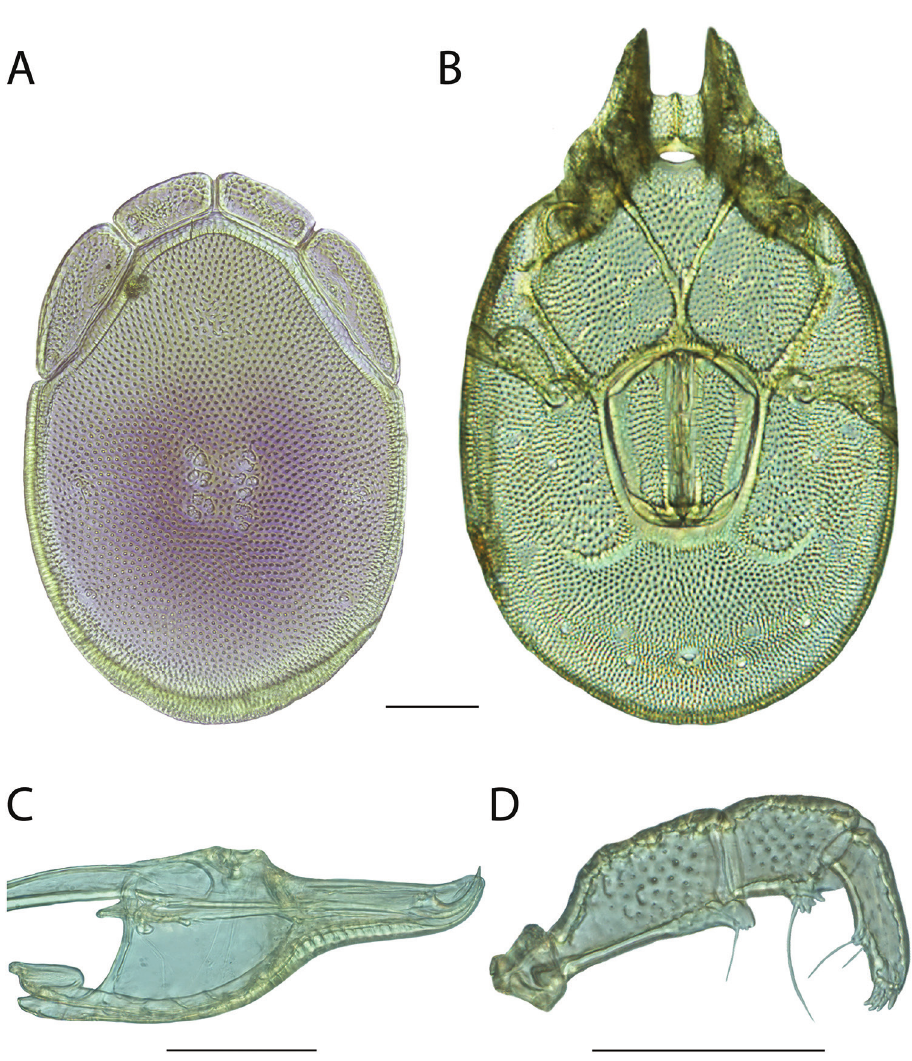
Figure 141. Torrenticola manni sp. n. female: A dorsal plates B venter (legs removed) C subcapitulum D pedipalp (setae not accurately depicted). Scale = 100